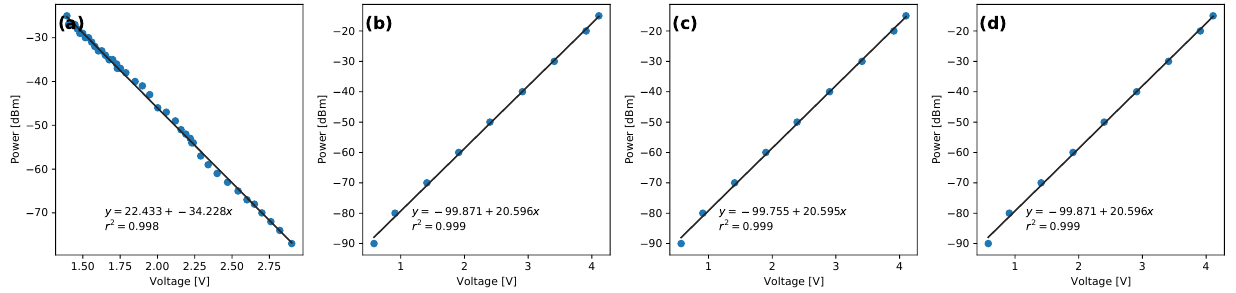
Figure 3. Received signal power vs. detector voltage read-out used for the calibration of the detectors. The black line indicates the fitted calibration curve: (a) Nokia, (b) RAL 38GHz horizontal, (c) RAL 38GHz vertical, and (d) RAL 26GHz.